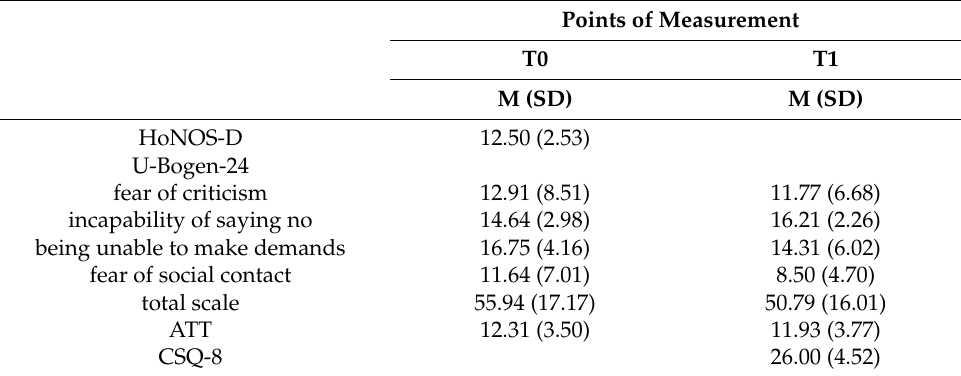
Table 4. Questionnaires descriptive statistics at their points of